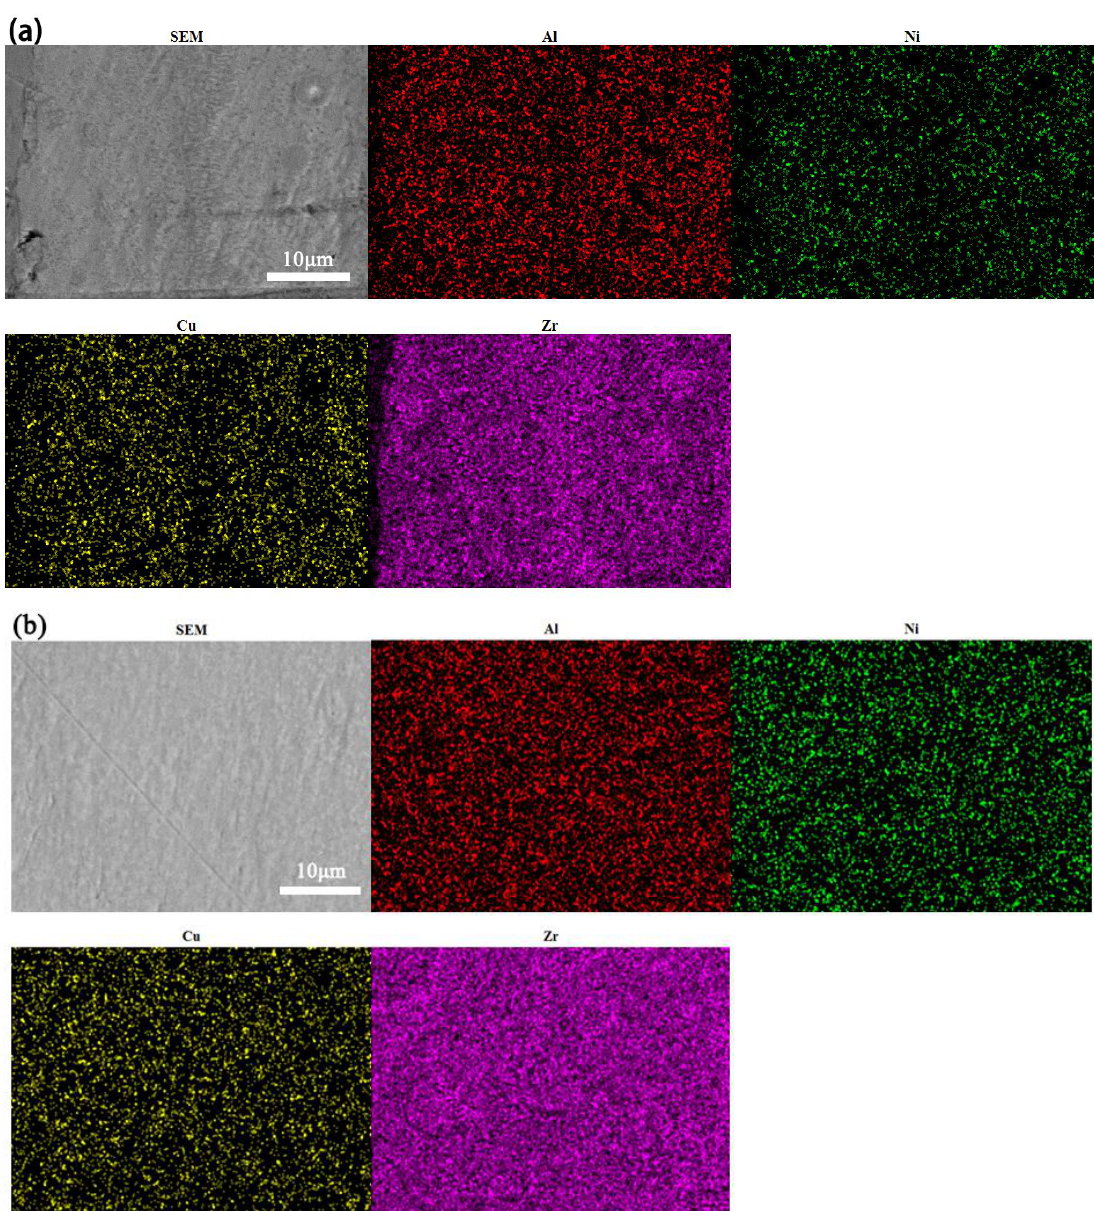
Figure 5. ( a ) The distribution of elements in the cross-section of amorphous alloy cladding layer. ( b ) The distribution of elements in the cross-section of crystalline powder cladding layer.